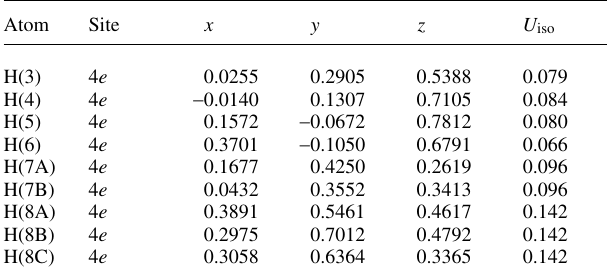
Table 2. Atomic coordinates and displacement parameters (in Å 2 ) .